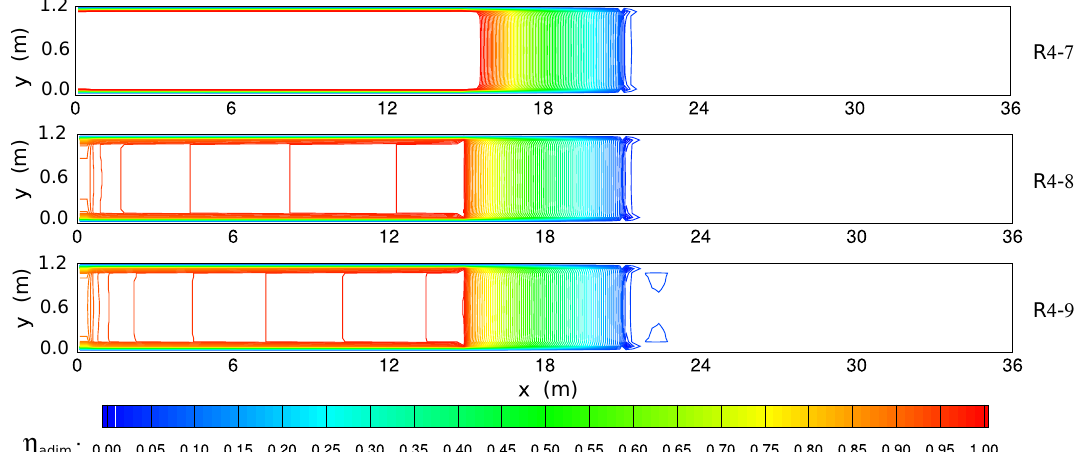
= ( η − η ) / ( η − η ) . adim min max min